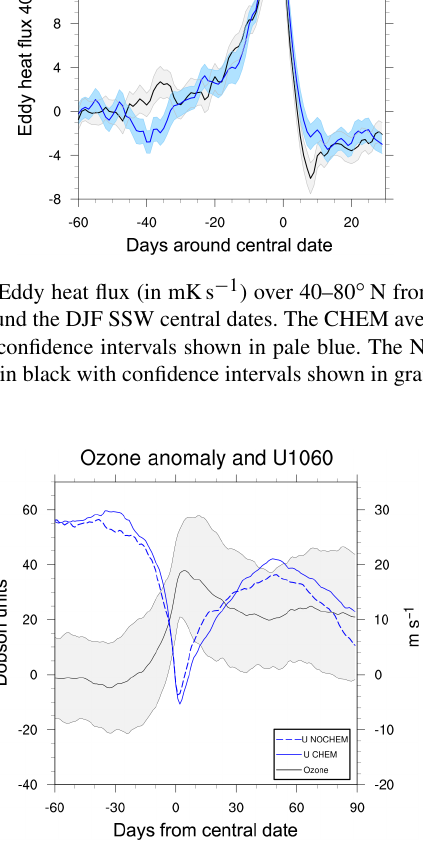
Figure 7. Composite of total column polar cap (over 60–90 ◦ N) ozone anomalies in Dobson units in the CHEM simulations and composites of zonal mean zonal wind at 60 ◦ N and 10hPa (in ms − 1 ) from − 60 to 90d around the central date of DJF SSWs in CHEM and NOCHEM. The black line shows the mean total ozone column; 1 σ from the mean is shaded. The solid and dashed blue lines show the mean U1060 in CHEM and NOCHEM, respectively.